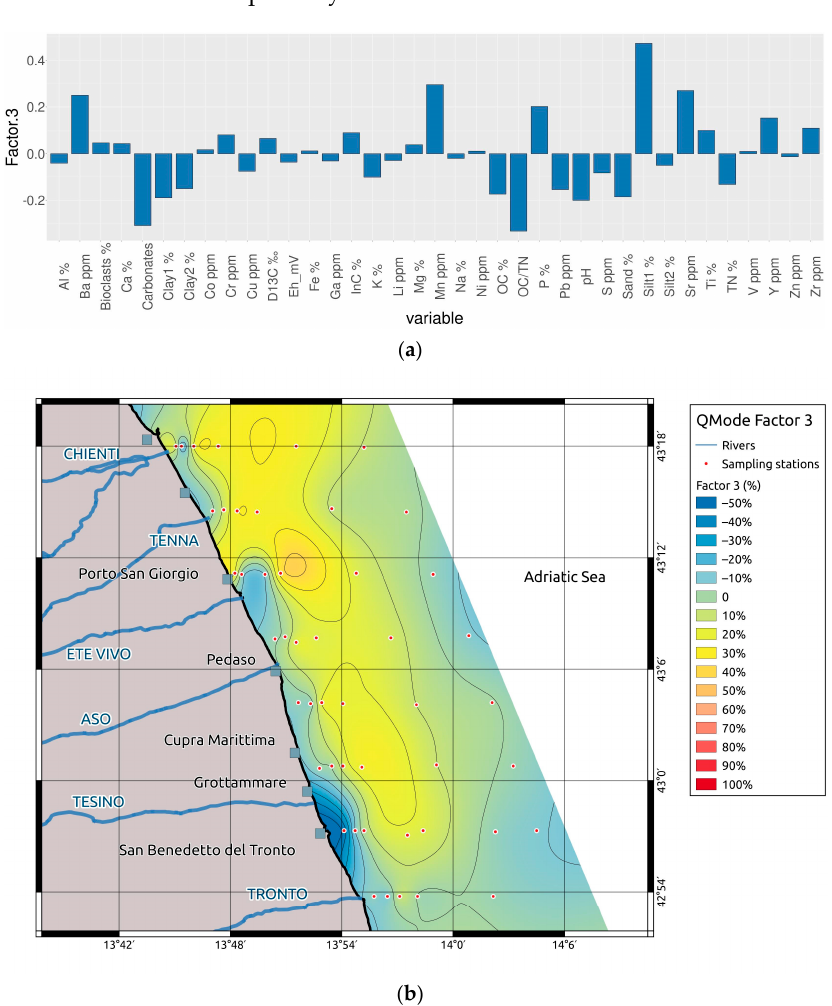
drain the limestone rocks of the Sibillini mountains. This means that the residual sedi- ments are partially associated with the carbonate rocks.